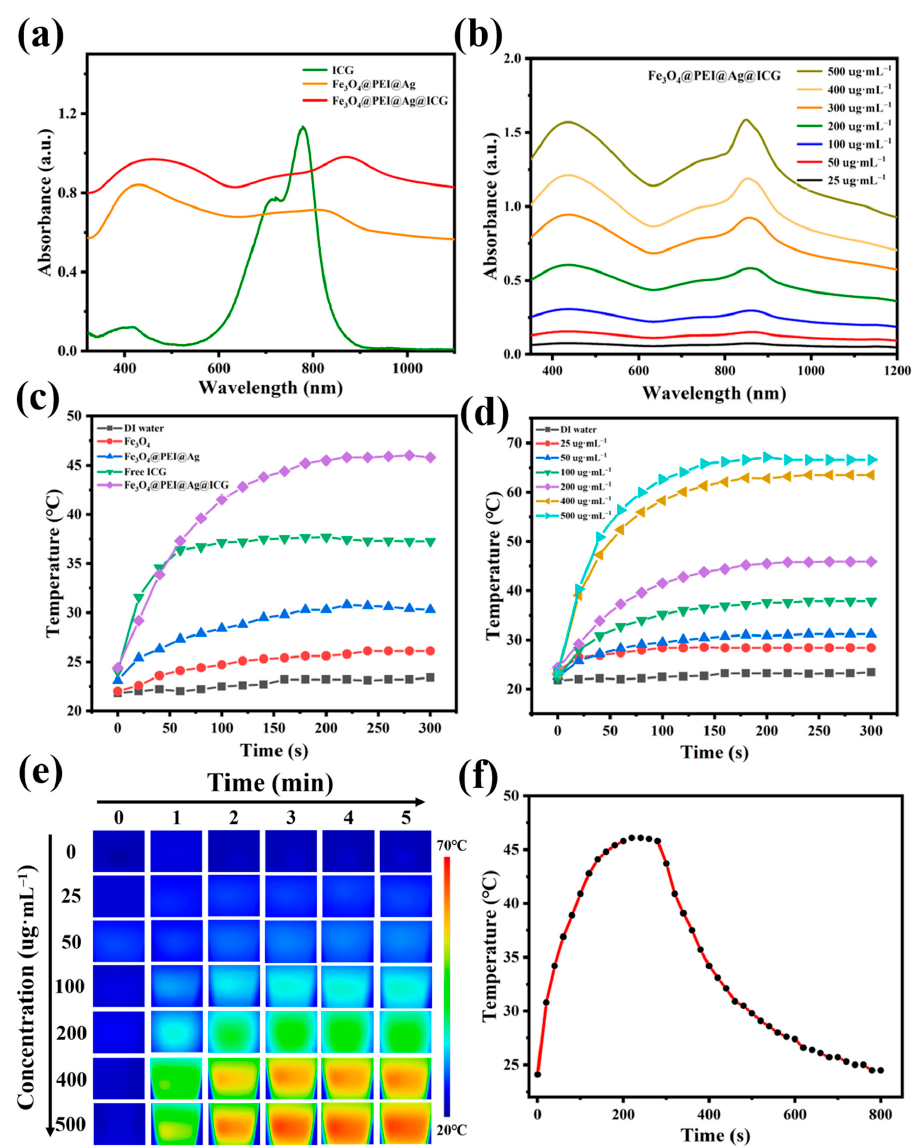
Figure 7. ( a ) Vis-NIR absorbance spectral of Fe 3 O 4 @PEI@Ag structure, ICG, and Fe 3 O 4 @PEI@Ag@ICG while dispersed in aqueous solution. ( b ) The Vis-NIR spectrum of